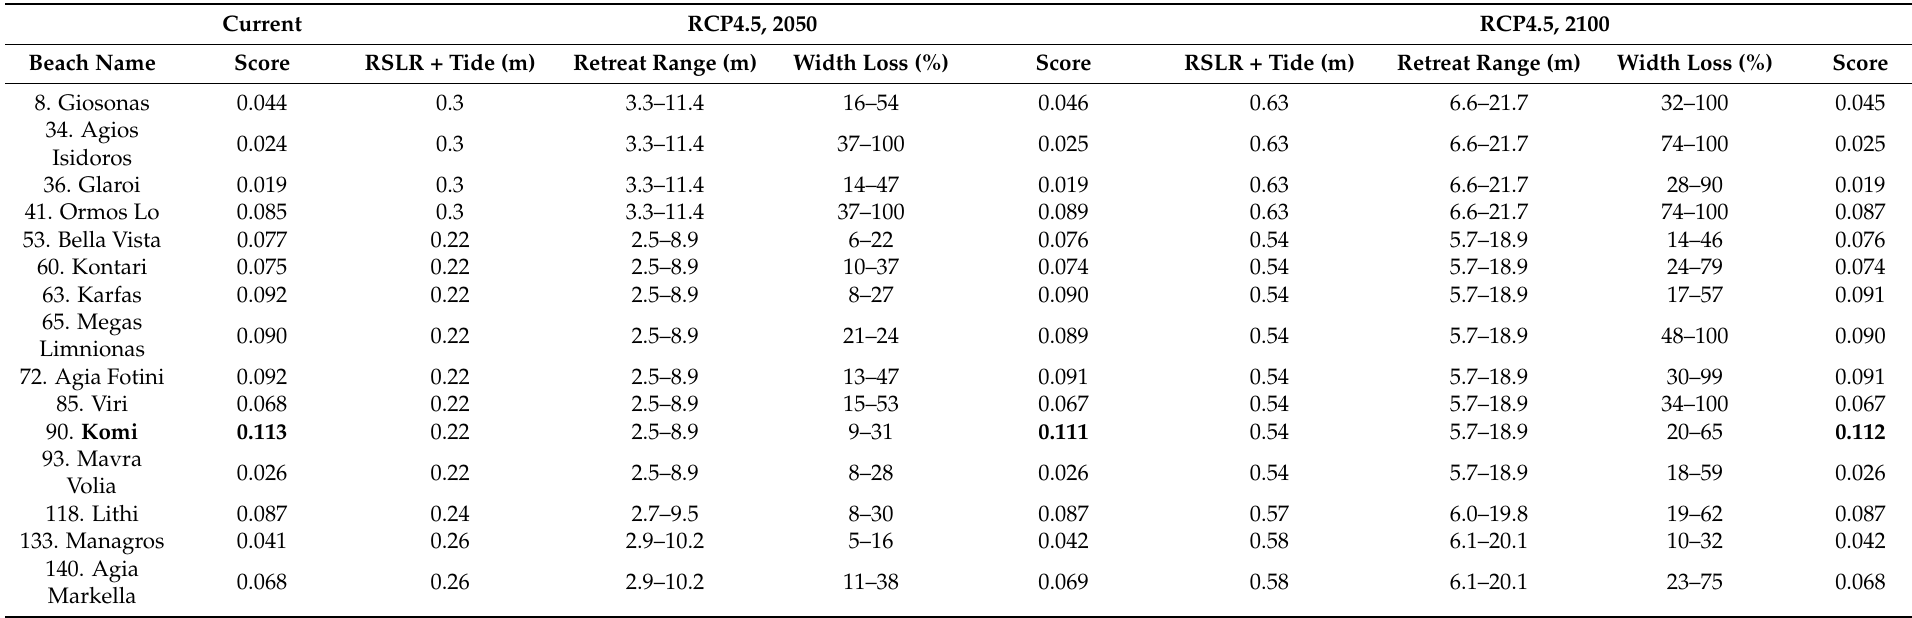
Table 2. Beach retreat results and ranking scores (AHP analysis) regarding the beach vulnerability to RSLR. Results are for the current status and future projections under the RCP4.5 emission scenario for the years 2050 and 2100. Width loss refers to the projected reduction of the max. beach width. For beach location see Figure